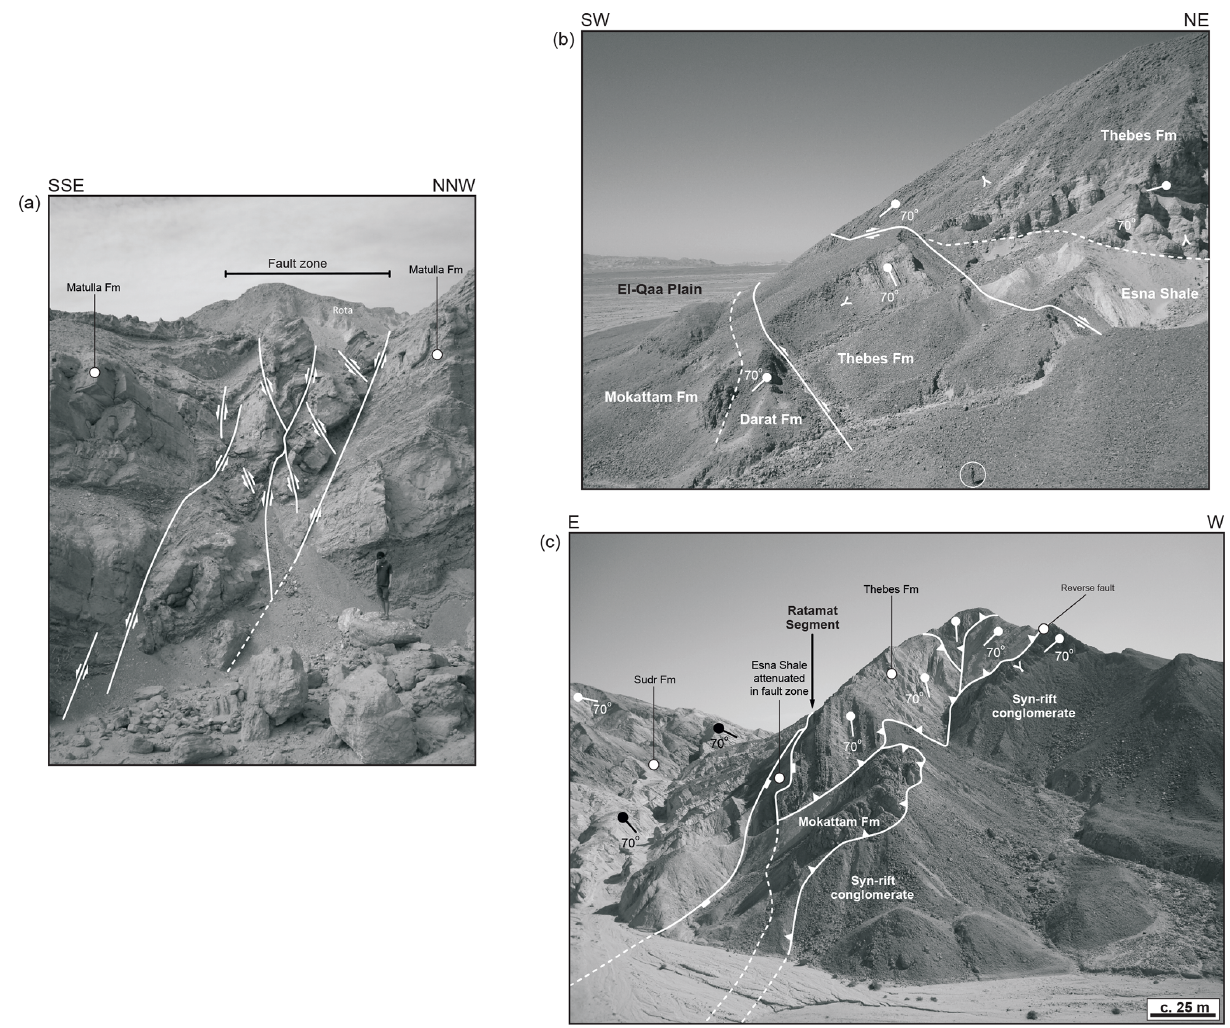
Figure 13. (a) Photograph showing the structure of a “secondary” normal fault zone associated with the Hadahid Fault System. (b) Pho- tograph looking obliquely (to the NW) at the southern end of the Ratamat Segment of the Hadahid Fault System. The monocline limb is deformed by reverse faults which thrust older pre-rift over younger pre-rift strata (i.e. right-hand reverse fault) or pre- over syn-rift strata (i.e. left-hand reverse fault). (c) Photograph looking obliquely (to the S) at the northern end of the Ratamat Segment. The Hadahid Fault System master fault is surface-breaching and is inferred to lie to the east of the network of reverse faults that dissected the strongly rotated middle limb of a precursor monocline. The reverse fault-bound block of pre-rift Thebes Formation is thrust onto overturned syn-rift strata. Locations of the photos are shown in Fig.